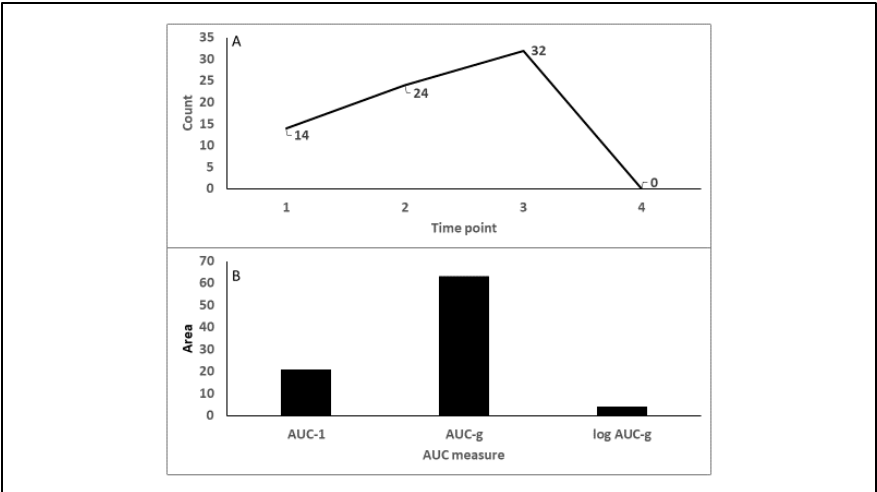
Figure 3. Observed values across three time points (observed trajectories; Panel A ) and calculated AUC values (Panel B ) for individual 10 from the N = 50 simulated data.